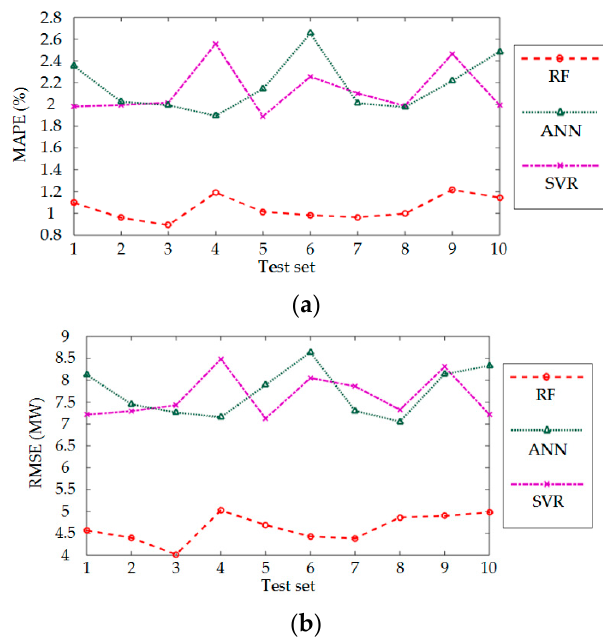
Figure 11. ( a ) MAPE of three predictors on the 10 test sets when 1 ‐ h ‐ ahead prediction is conducted; ( b ) RMSE of three predictors on the 10 test sets when 1 ‐ h ‐ ahead prediction is conducted.